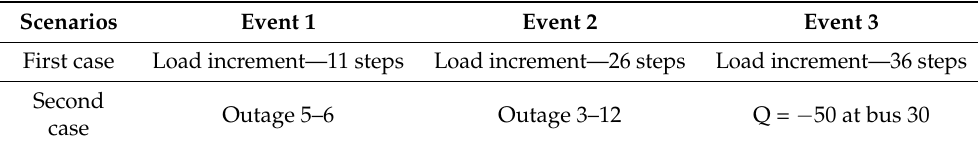
Table 1. Testing scenarios.